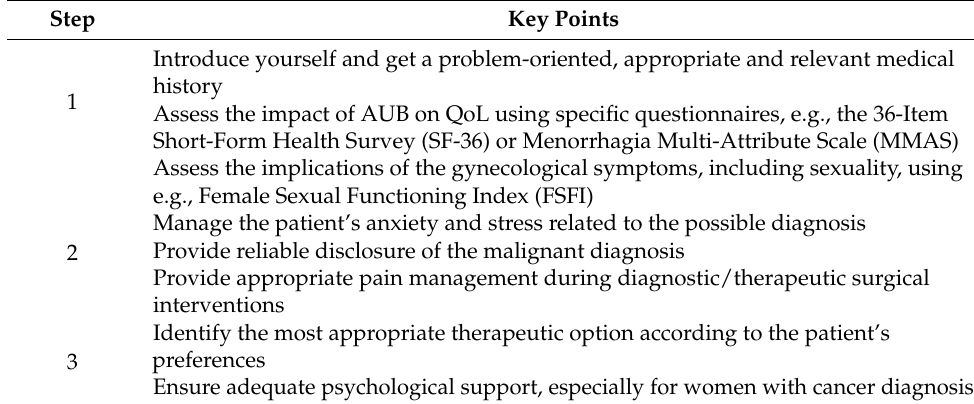
Table 1. Three-step multidisciplinary approach for postmenopausal women with intrauterine pathologies